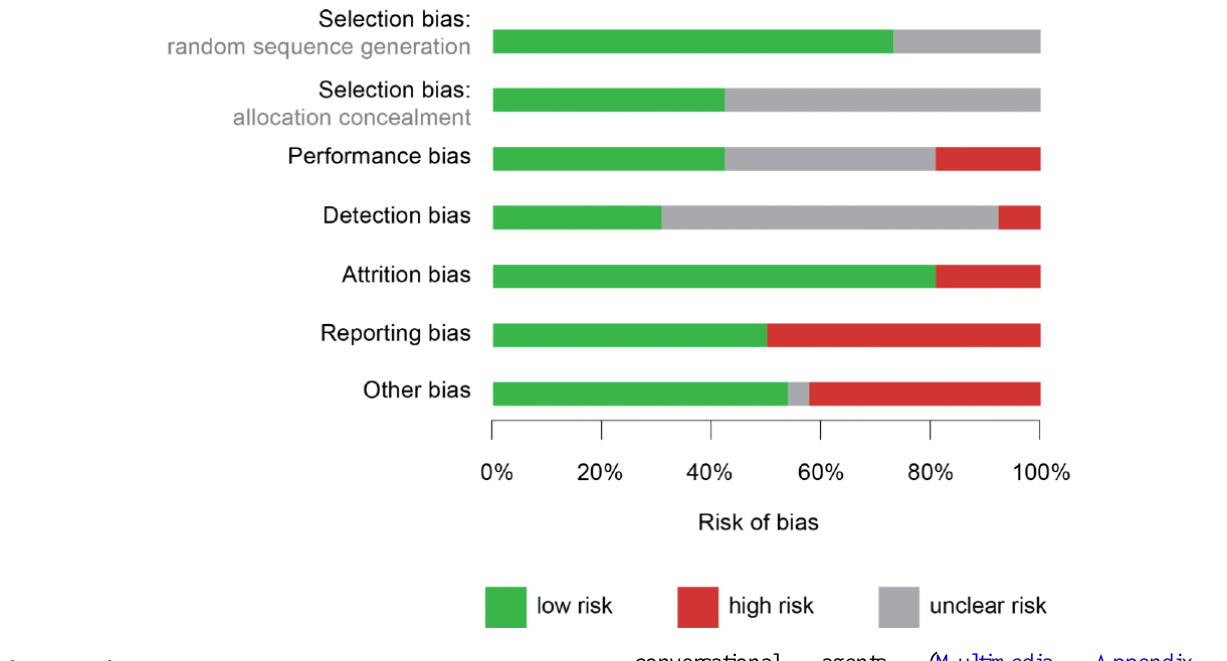
Figure 6. Risk of bias presented as percentages across all 26 studies included in the